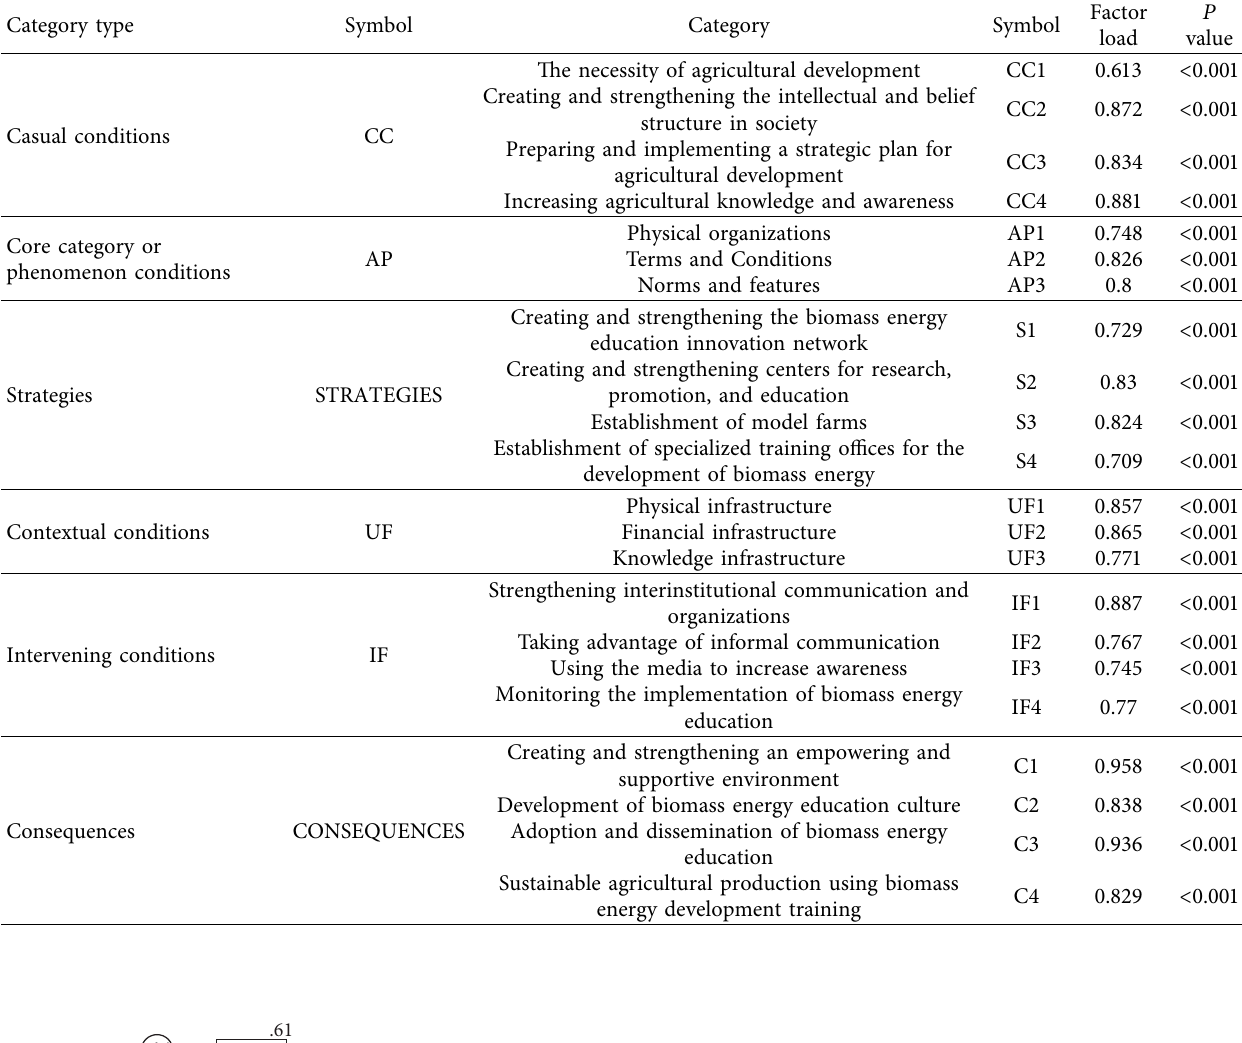
Table 6: Te total measurement model of the policy-making model of biomass energy development education in agriculture. Category